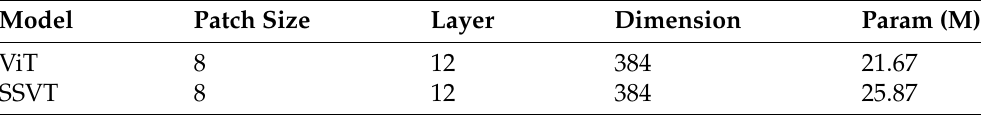
Table 3. The transformer model